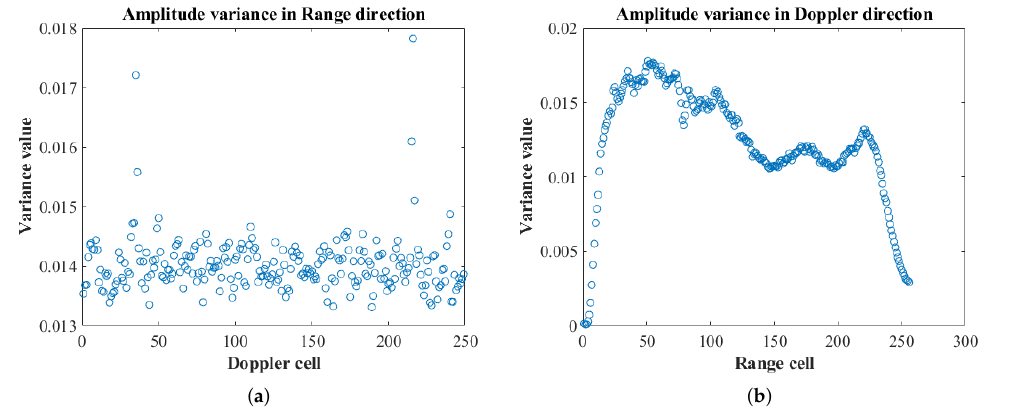
Figure 8. Background noise amplitude dispersion in RDM matrix ( a ) Noise amplitude variance in range direction. ( b ) Noise amplitude variance in Doppler direction.